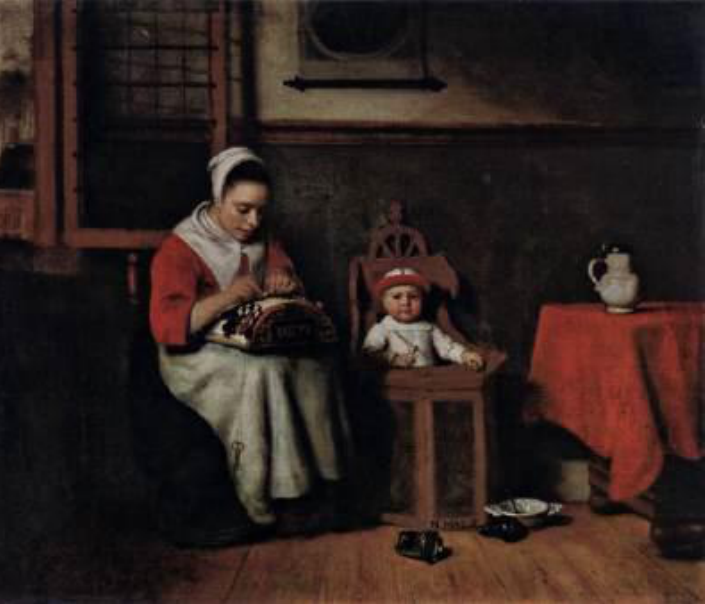
Figure 7. Nicholas Maes, The Lacemaker , 1656 – 1657, Oil on canvas, 45 × 53 cm, Metropolitan Museum of Art, New York.